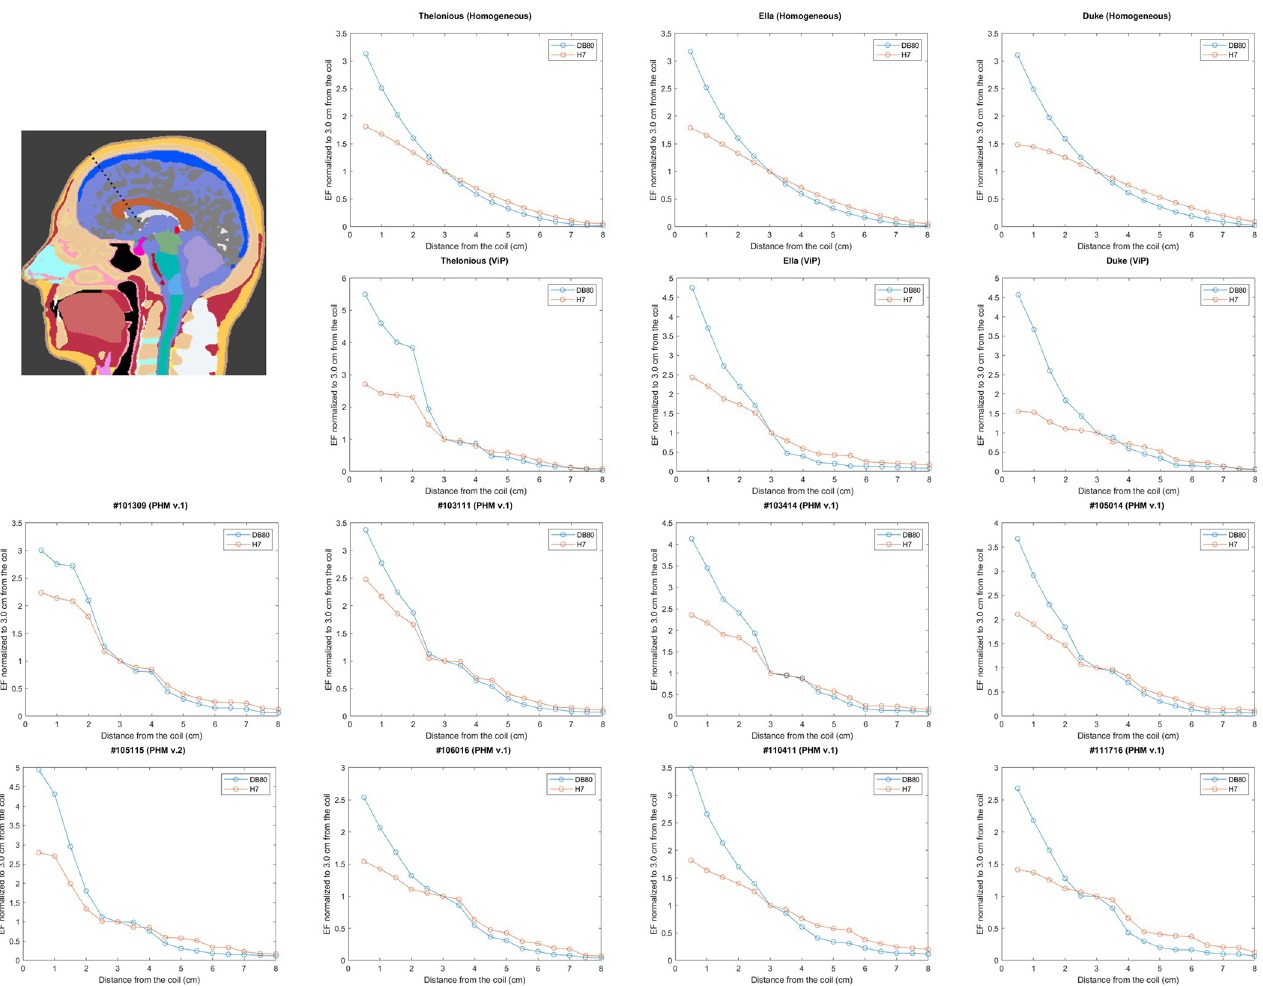
Fig 5. Field decay profile. The electric field magnitude as a function of the distance from the coil, is shown for the D–B80 coil and for the H7 coil, when located at the treatment location over the prefrontal cortex. The field was measured along a line in a central sagittal plane starting at the point of inflection of the frontal bone and going at 45˚ downward and posteriorly (top left). The electric field was normalized to the field at a depth of 3 cm from coil surface. Shown results for the 14 numerical head models.